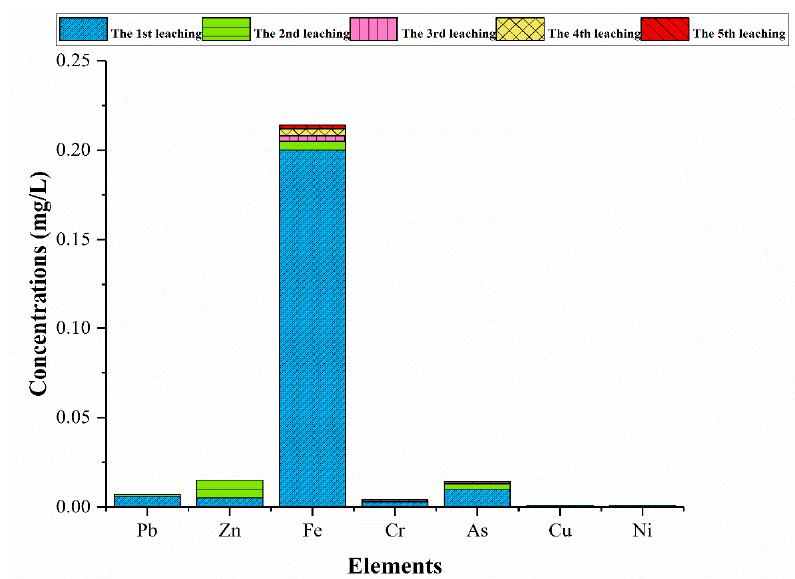
Figure 9. Concentration of metal ions in dynamic leaching of cemented paste backfill (CPB) samples.